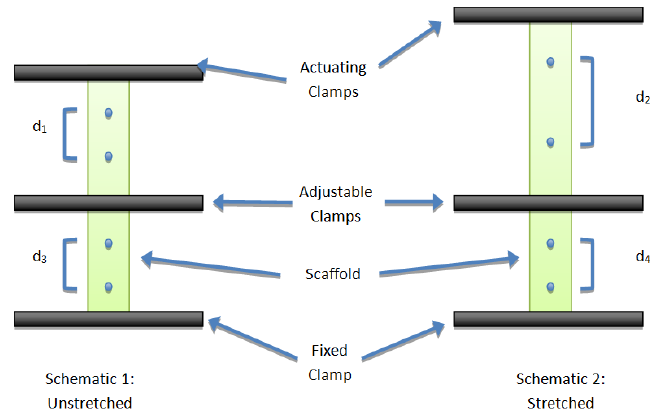
Figure 3. Two schematics of the strain characterization. Schematic 1 represents the photo of an unstretched scaffold. Schematic 2 represents a picture of the same scaffold under a specified stretch. Comparing to Figure 4, d and d are markers inside of zone B. 4